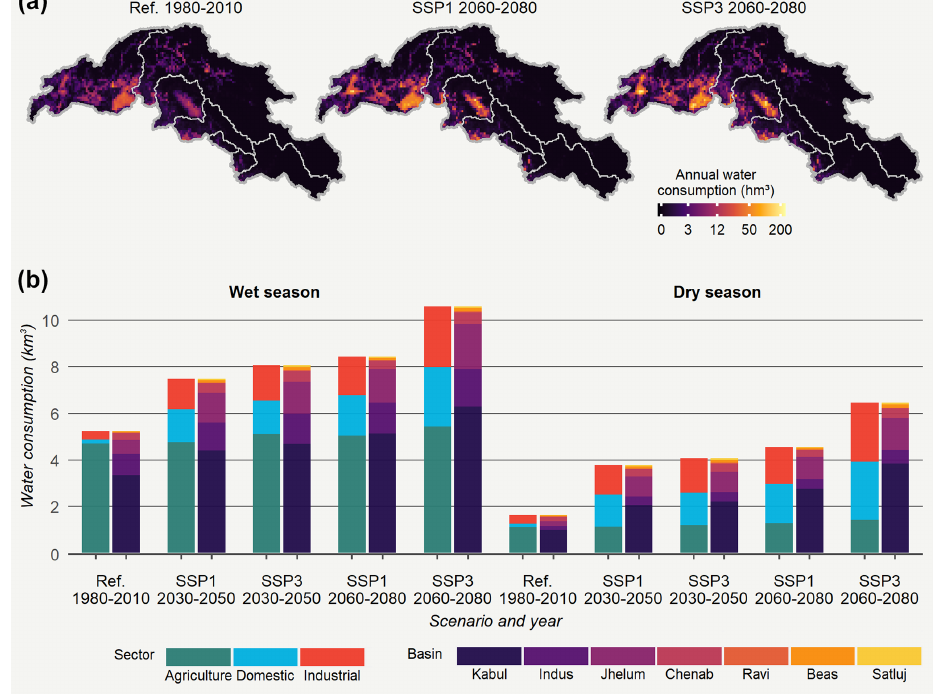
Figure 3. Spatially (a) , seasonally and sectoral (b) disaggregated water consumption in the sub-basins of the upper Indus Basin. Agricultural water use is based on the ensemble mean. The total height of the bars (b) indicates total water use in the upper